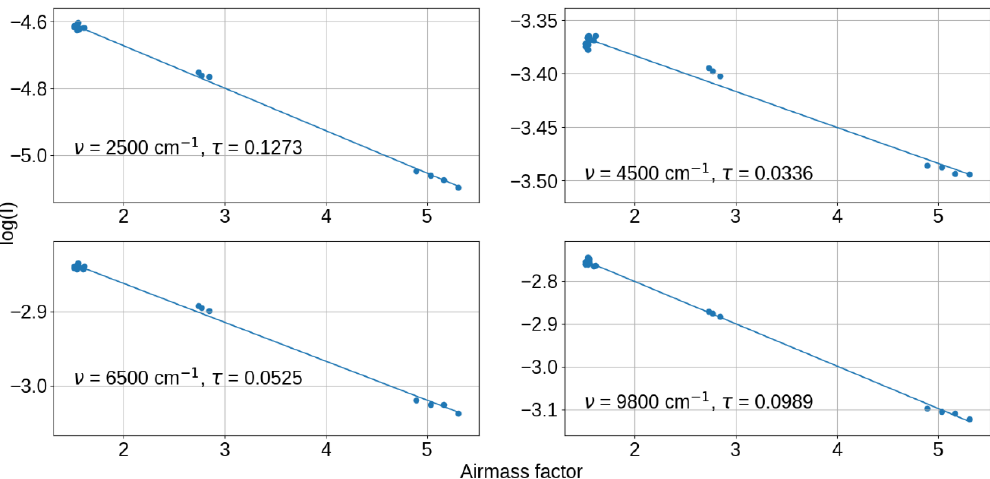
Figure 2. Langley plots from selected wavenumbers in the near-infrared atmospheric windows, along with the total optical depth obtained at that wavenumber. Taken from observations of 18 September 2008.